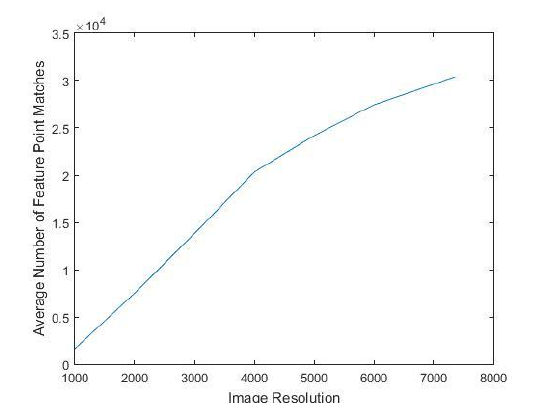
Figure 9. Average number of feature point matches of different resolution image sets